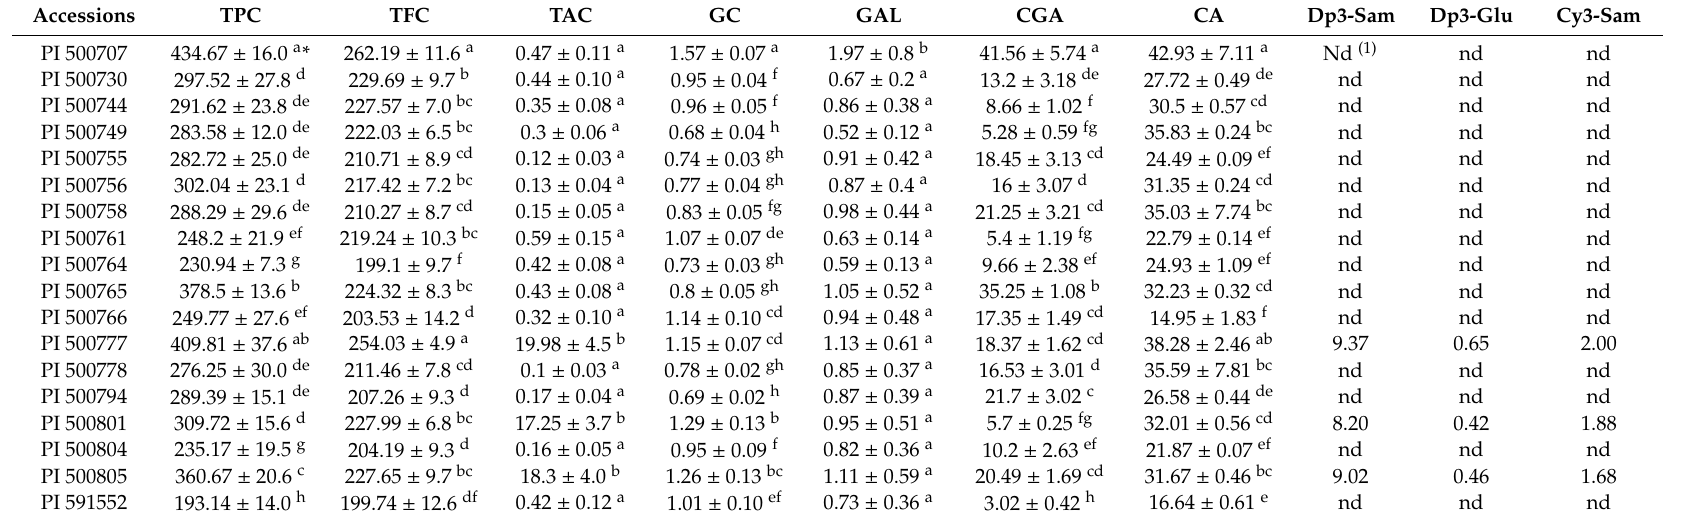
Table 2. Contents of phenolic compounds in leaf extracts from 18 di ff erent H. acetosella accessions (mean value ± S.D., n =